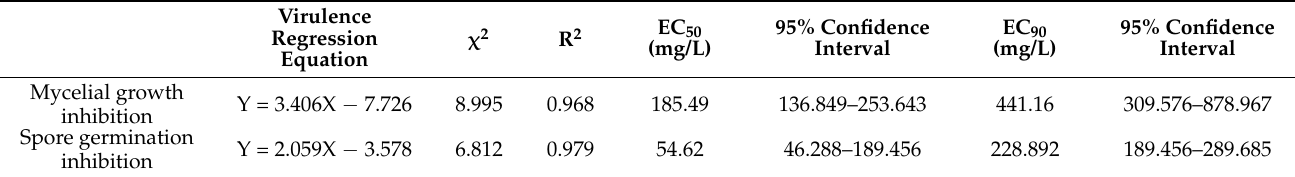
Table 1. Virulence regression equation of 6-MCM against V. mali